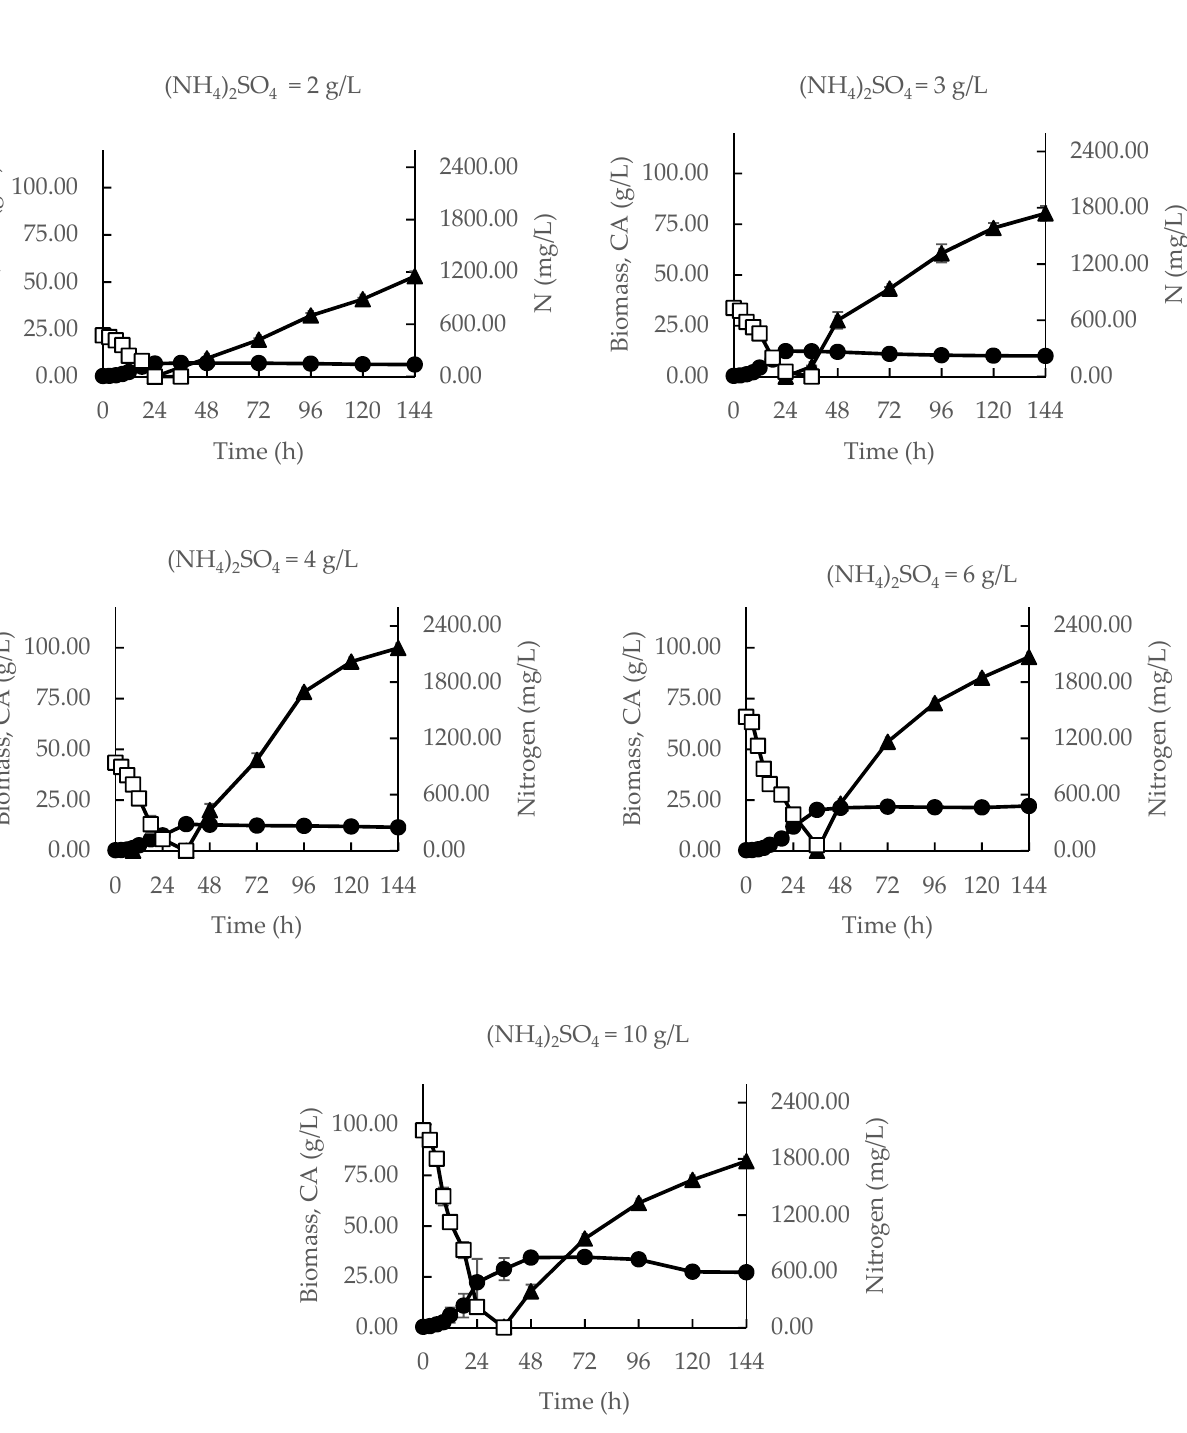
Figure 1. Citric acid production by yeast Y. lipolytica VKM Y-2373 at different concentrations of ammonium sulfate ( ● —biomass; ▲ —CA; □ —nitrogen). Table 1 summarizes data on the parameters of yeast growth and CA accumulation of Y. lipolytica VKM Y-2373. The biomass production was significantly different when the concentration of (NH 4 ) 2 SO 4 was increased from 2 to 10 g/L. Thus, the biomass production of cells grown at 10 g/L (NH 4 ) 2 SO 4 was 4.3 times higher than the cells grown at 2 g/L (NH 4 ) 2 SO 4 .